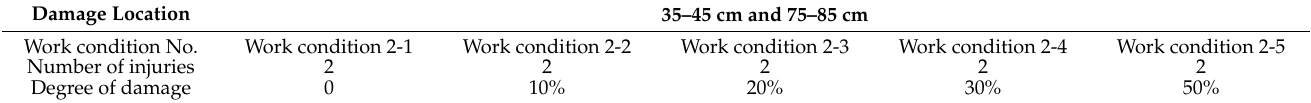
Table 2. Work condition 2 damage information.